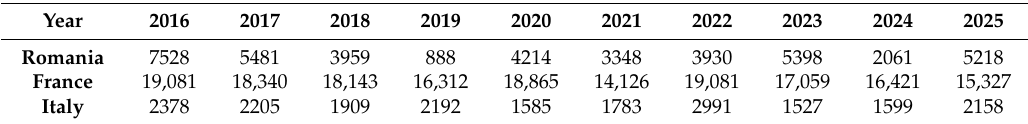
Table 4. Estimation of the bioethanol production from cereals (in million liters of absolute alcohol). Source: authors’ own calculation based on [56].